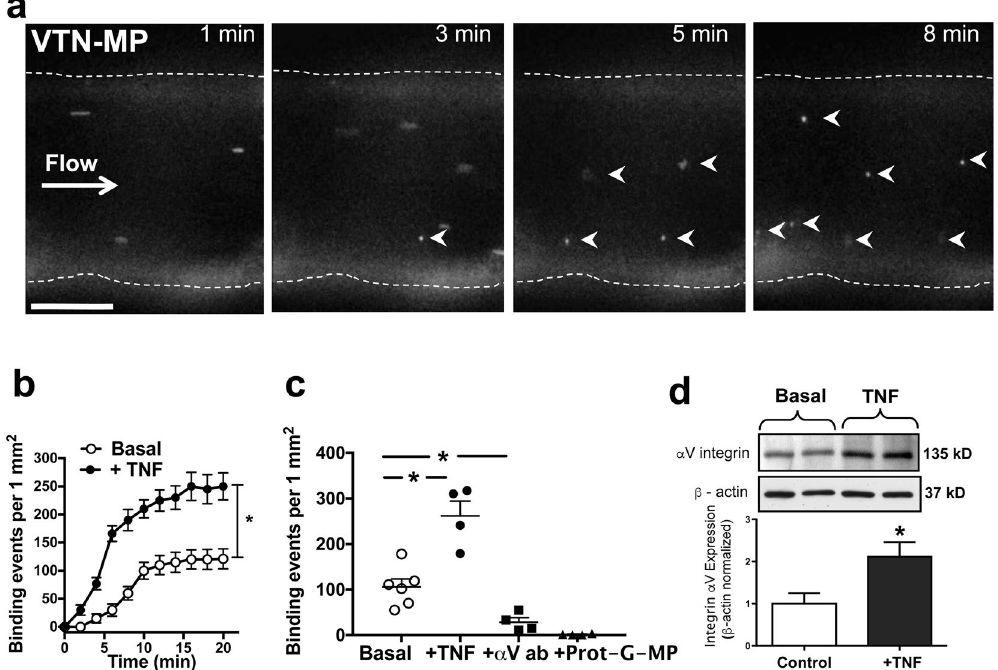
Figure 1. Microparticle (MP) binding under flow in the isolated middle cerebral artery. ( a ) Fluorescence images of representative time-lapse recording demonstrate firm binding of VTN-MPs (0.1 µ g/ml) on the luminal surface of the isolated mouse MCA in the presence of physiological pressure and flow (white arrowheads show stationary MPs). Scale bars: 50 μ m. ( b ) Summary data (n = 4–6) show the rate and number of binding events of VTN-MPs in the absence (basal) or presence of TNF (7 ng/ml, 4-hour), or after incubating with α V integrin blocking antibody, or after delivery of Protein G conjugated MPs ( c,d ) Representative images and summary data of Western immunoblot shows increased expression of α V integrin on TNF-exposed mouse MCA. Data are shown as mean ± S.E.M; * p <